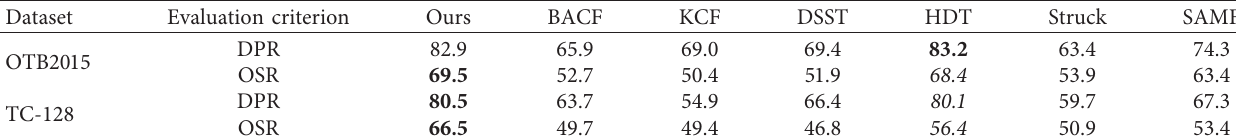
Table 2: Comparisons with the state-of-art tracker in terms of DPR and OSR (%), including BACF, KCF, DSST, HDT, Struck, and SAMF on OTB2015 and TC-128 datasets. The first and second best values are highlighted in bold and italics.